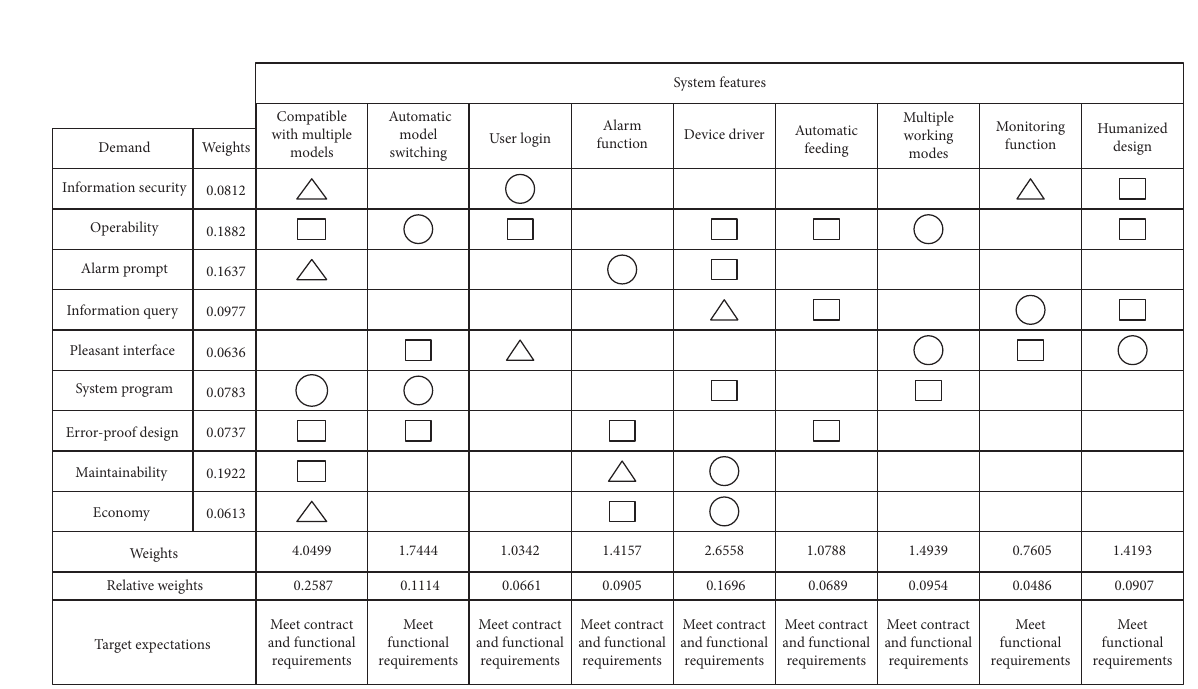
Figure 7: HoQ of the functional planning for the control service system.